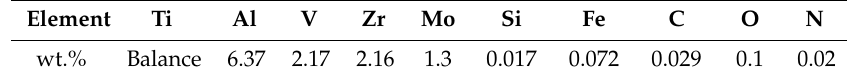
Table 1. Chemical composition of TA15 powder used in the experiment.